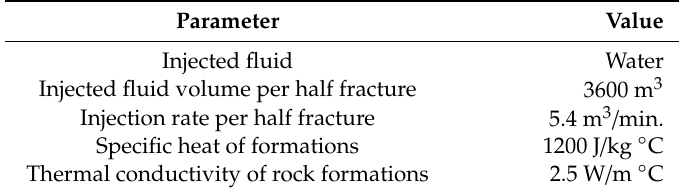
Figure 16. 3D ½ model showing injection points of fractures 1, 2, and 3 with (a) 60 m fracture spacing, (b) prevailing minimum horizontal stress before fracturing, and (c) minimum horizontal stress after fracturing.